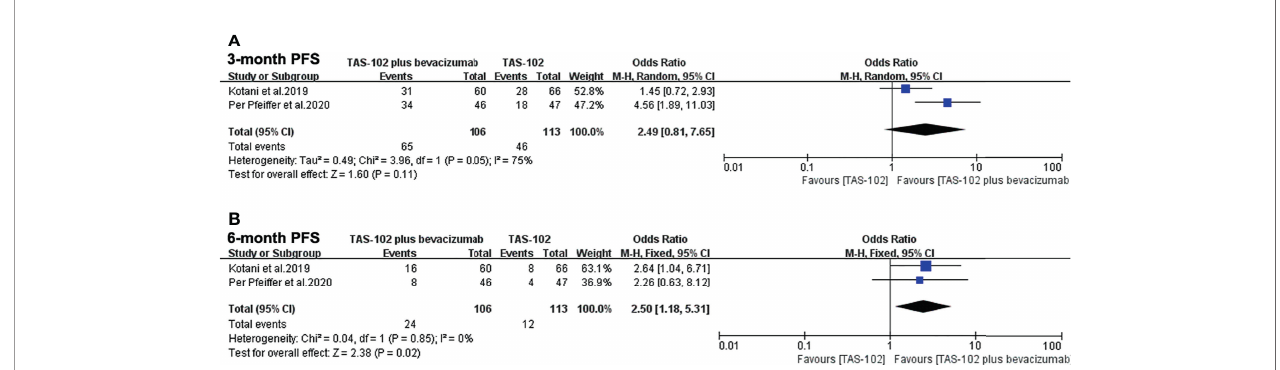
FIGURE 4 | Forest plot of pooled relative risk for progress free survival from included studies. (A) 3-month progress free survival. (B) 6-month progress free survival. Horizontal lines represent 95% con fi dence intervals (CIs). M-H, Mantel-Haenszel; df, degrees of freedom; DFS, disease-free survival.